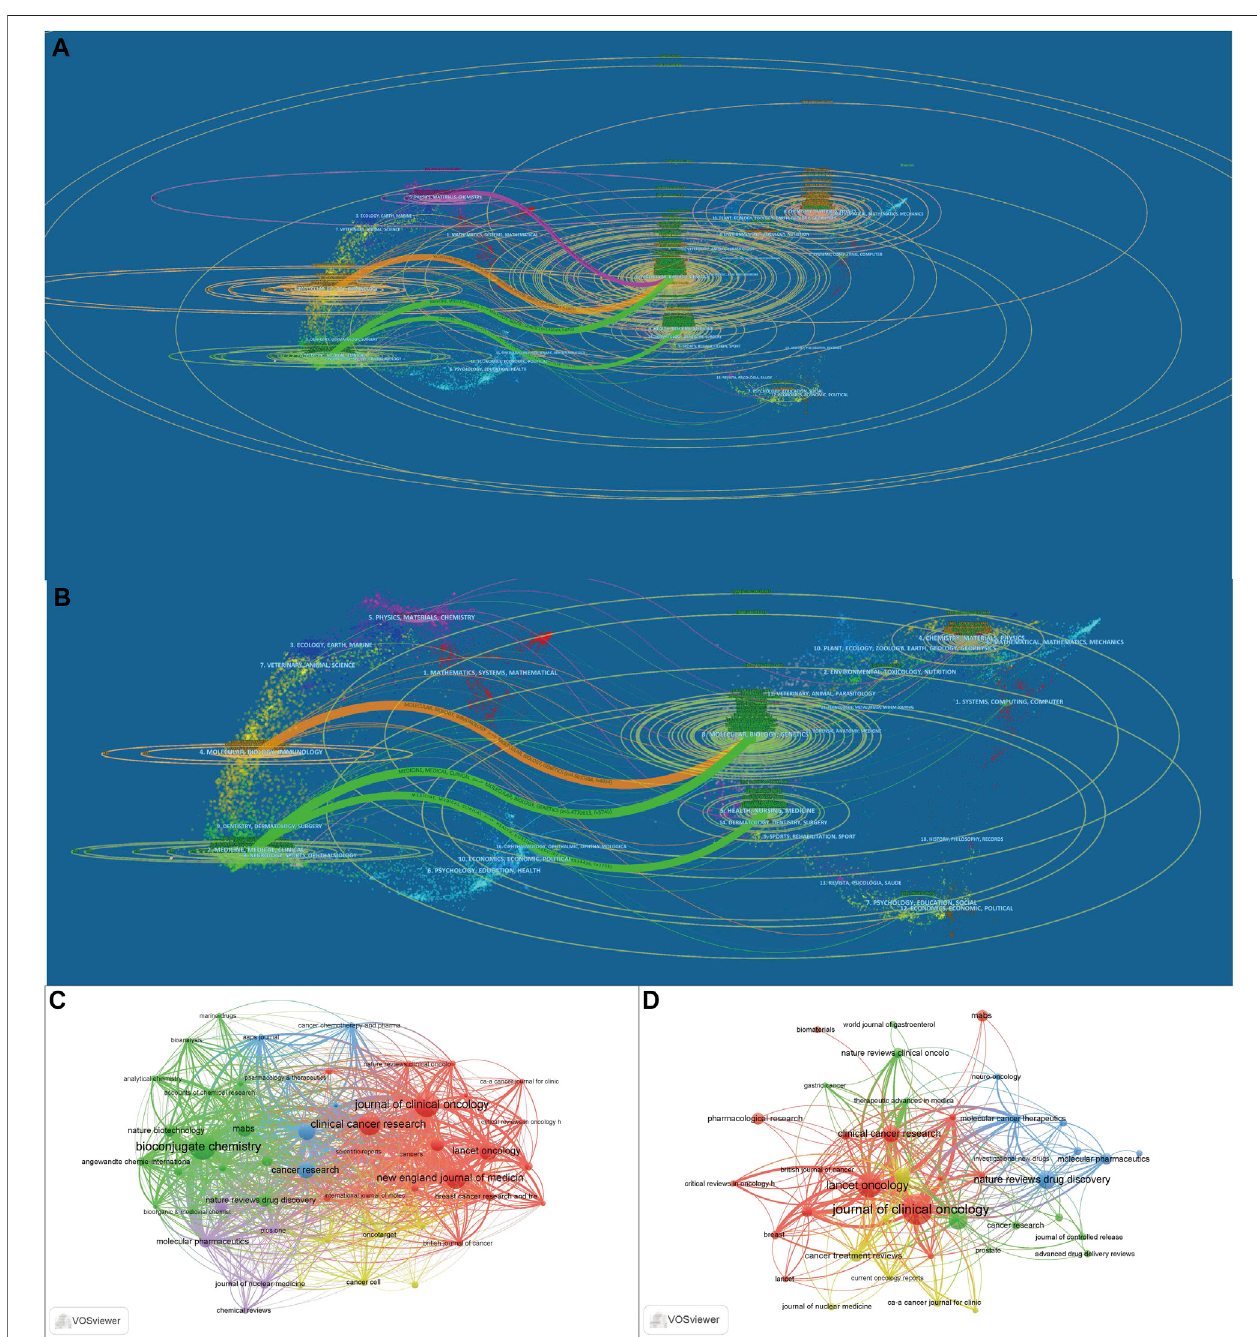
FIGURE 4 | The dual-map overlay of journals and network map of cited journals related to ADC research in the solid cancer fi eld. (A,B) . The dual-map overlay of journals for holistic and clinical research, respectively. (C,D) . The network map of cited journals for holistic and clinical research, respectively.